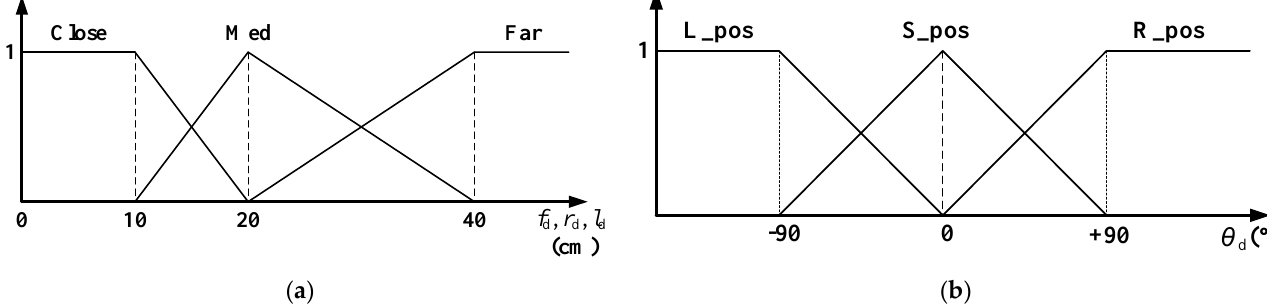
Figure 6. Membership functions for the fuzzification of input data: ( a ) membership function for the fuzzification of distance